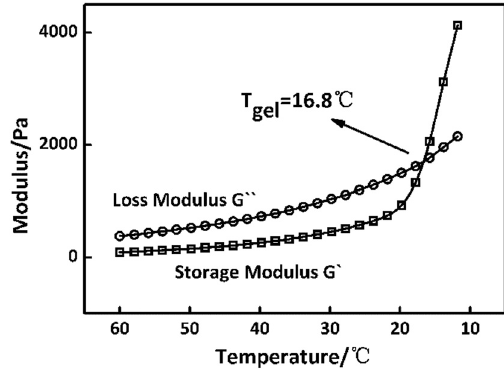
Figure 1: Temperature dependence of the storage modulus G ′ and the loss modulus G ″ of PAN